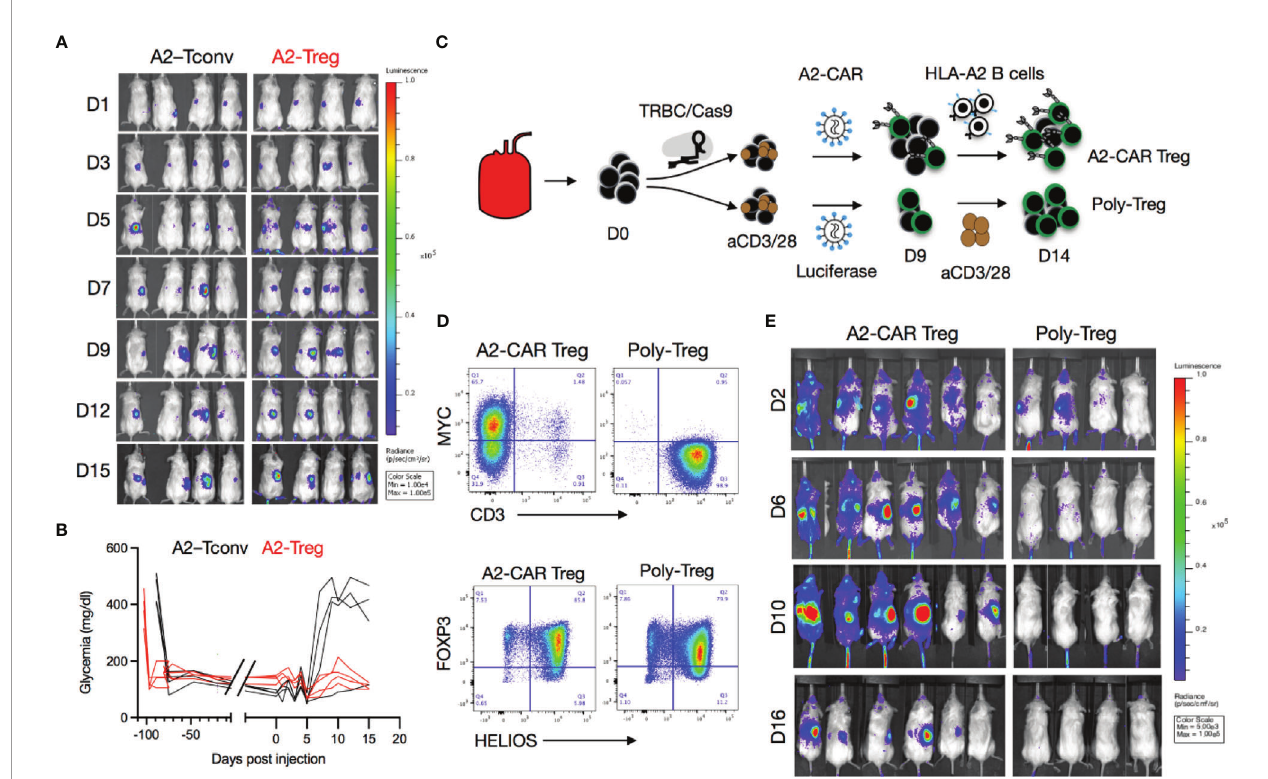
FIGURE 3 | Traf fi cking of A2-CAR Tregs to islet grafts. (A) TCR de fi cient ( TRBC -CRISPR edited), lentiviral transduced, 2 x 10 6 A2-CAR CD4 + Tconv cells or A2- CAR Tregs, (harvested on Day 10 after sorting from peripheral blood of an HLA-A2 negative donor) were infused into mice that had been stably transplanted with HLA-A2 transgenic mouse islets. Luciferase activity of A2-CAR CD4 + Tconv cells or A2-CAR Tregs over time is shown. (B) Glycemia was monitored over time after cell infusion. (C) Tregs were edited with CRISPR/Cas9 ribonucleoprotein (RNP) complexes targeting the TRBC locus after cell sorting, activated with anti-CD3/28 beads, and transduced with a lentivirus consisting of an A2-CAR linked to a luciferase reporter gene by a 2A self-cleaving peptide two days later. On Day 9, Tregs were re-stimulated with HLA-A2 + stimulated B cells (sBCs) for another 5 days and were thereafter injected in diabetic mice (2 x 10 6 /animal) transplanted with HLA-A2 + human islets. In parallel, polyclonal Tregs were activated with anti-CD3/28 beads, transduced with a lentivirus expressing a luciferase reporter gene alone, and restimulated with anti-CD3/28 beads on Day 9 and injected on Day 14 in diabetic mice (2 x 10 6 /animal) transplanted with HLA-A2 + human islets. (D) Editing ef fi ciency was measured by MYC-tag and CD3 surface expression in two independent donors. Treg purity was assessed by FOXP3 and HELIOS expression in the same donors. (E) Luciferase activity of A2-CAR Tregs and polyclonal Tregs (transduced with a lentivirus expressing a luciferase reporter alone) over